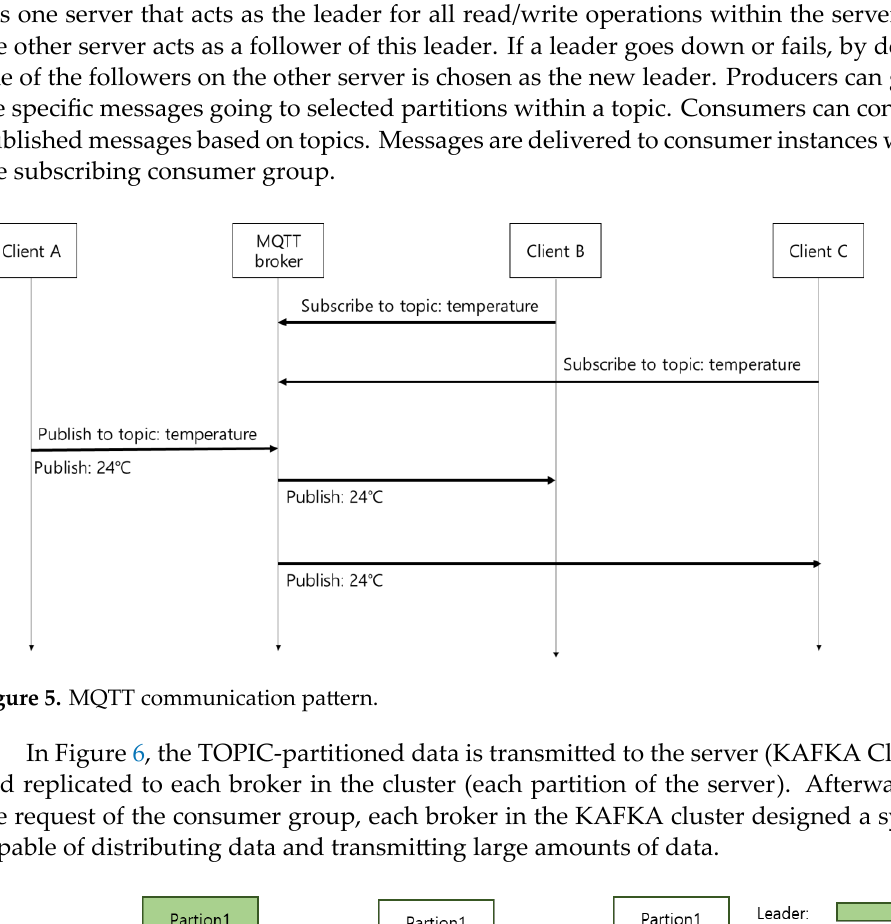
Figure 4. Data publication architecture.